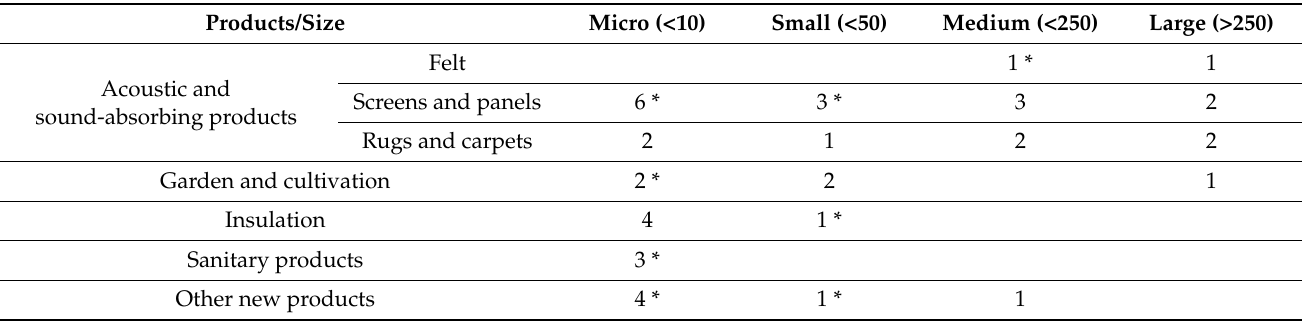
Table 3. Overview of producers by company size (number of employees) and type of